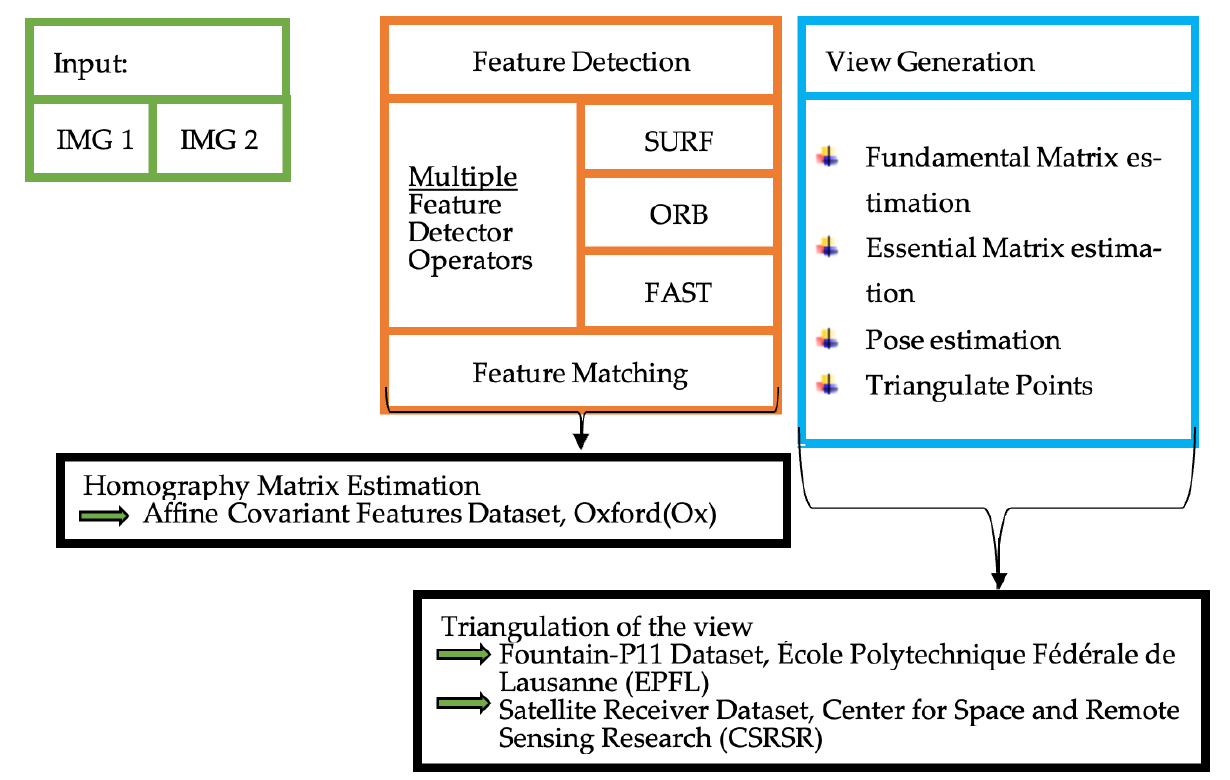
Figure 1. Workflow of the two-view SfM algorithm with the implementation of multiple FDOs.